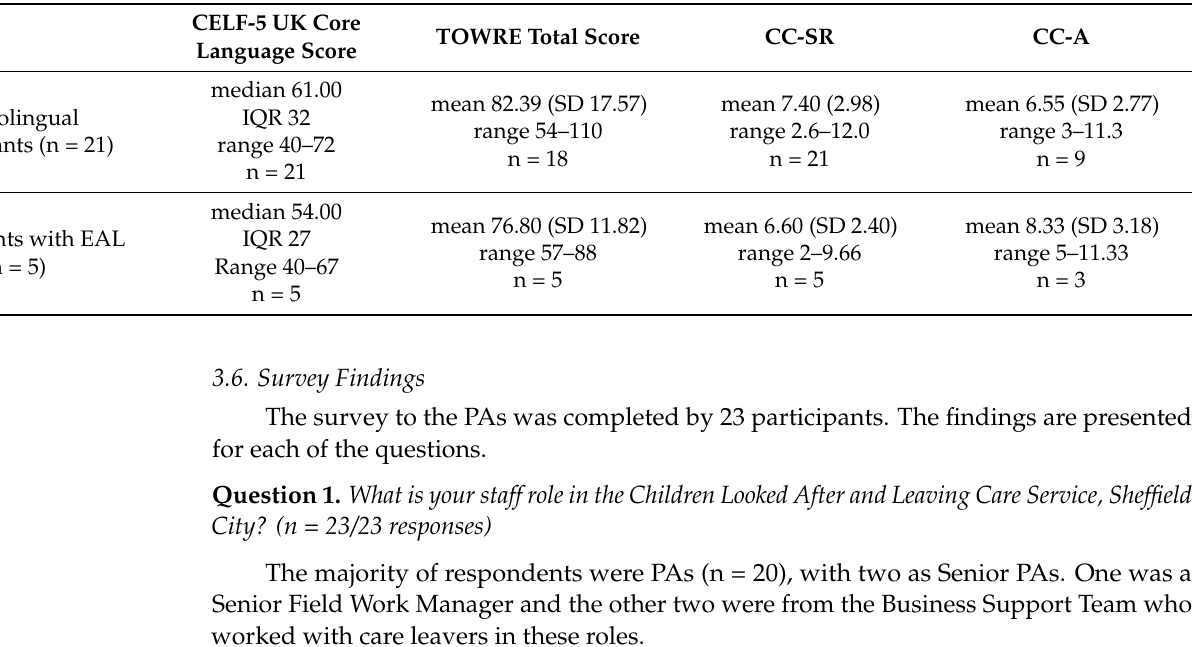
Table 5. Profile of the participants with very low/severe CELF-5 UK scores who are monolingual (n = 21) compared to participants with EAL (n =